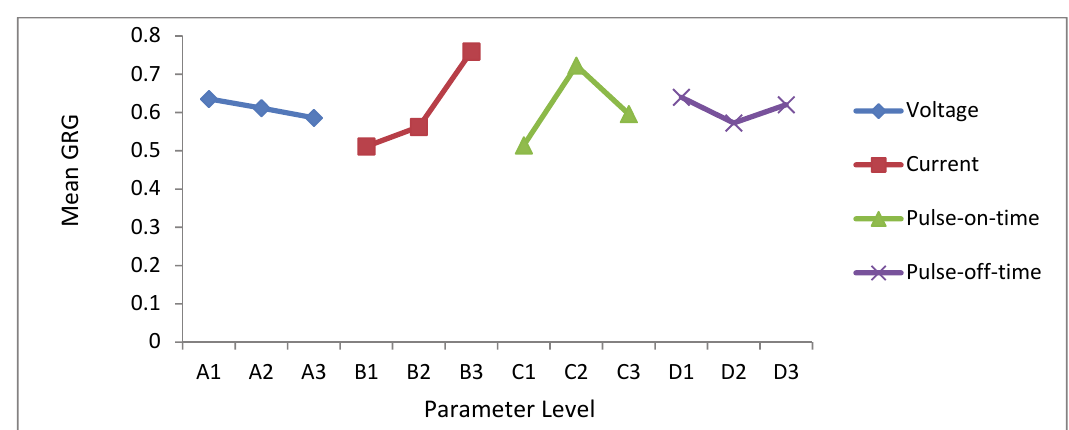
Fig. 4. Response graph of WSN ratio